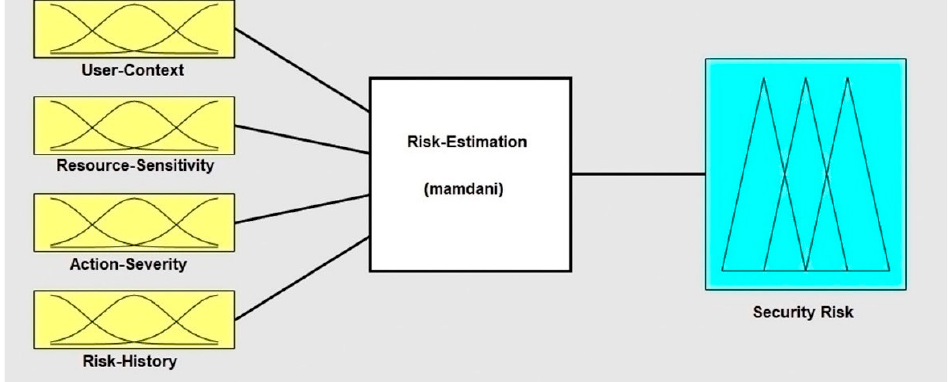
Figure 3. Implementation of Mamdani FIS using the MATLAB fuzzy logic toolbox.